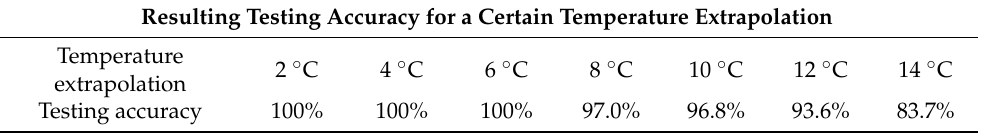
Table 10. Resulting testing accuracy over temperature extrapolation. The extrapolated temperatures were not used for the model building and only used for